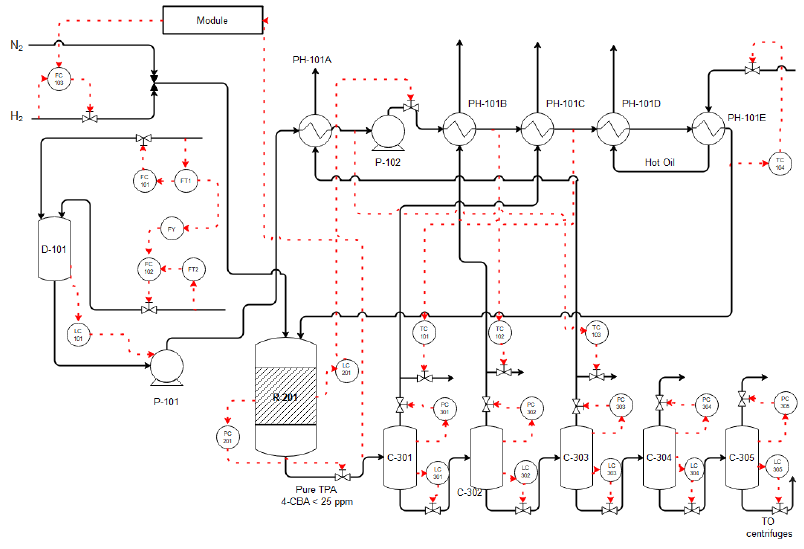
Figure 11. Flow sheet of the industrial hydropurification plant for TPA with improved PID control. Adapted from [68].